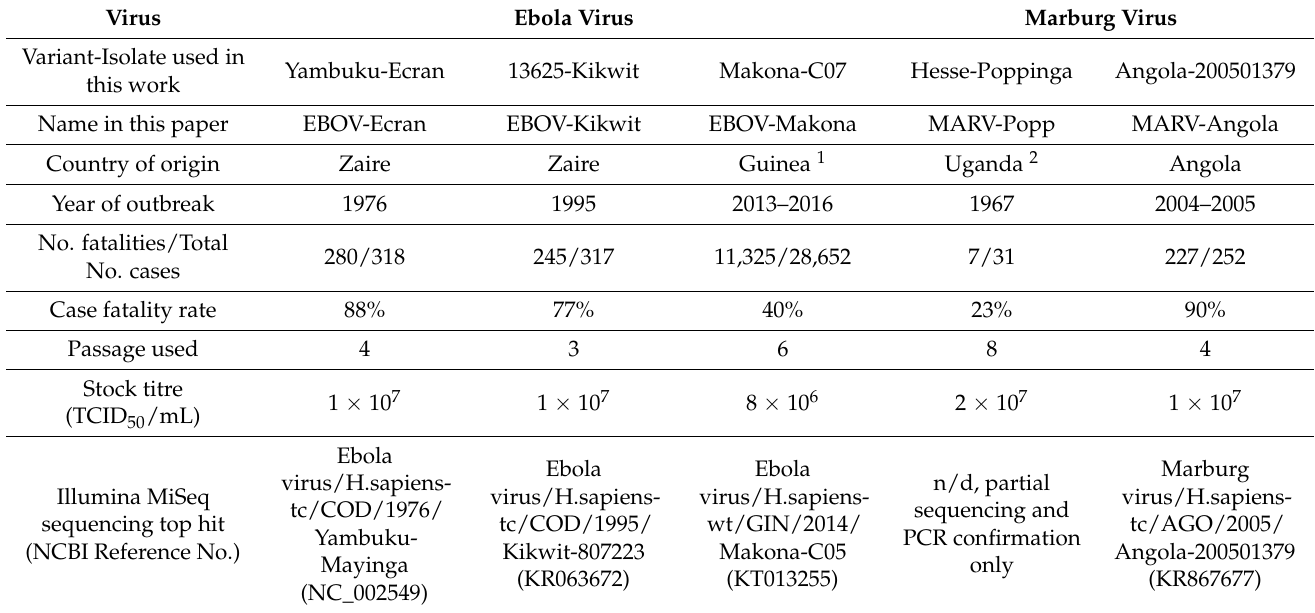
Table 1. Summary of Ebola virus and Marburg virus types discussed in this